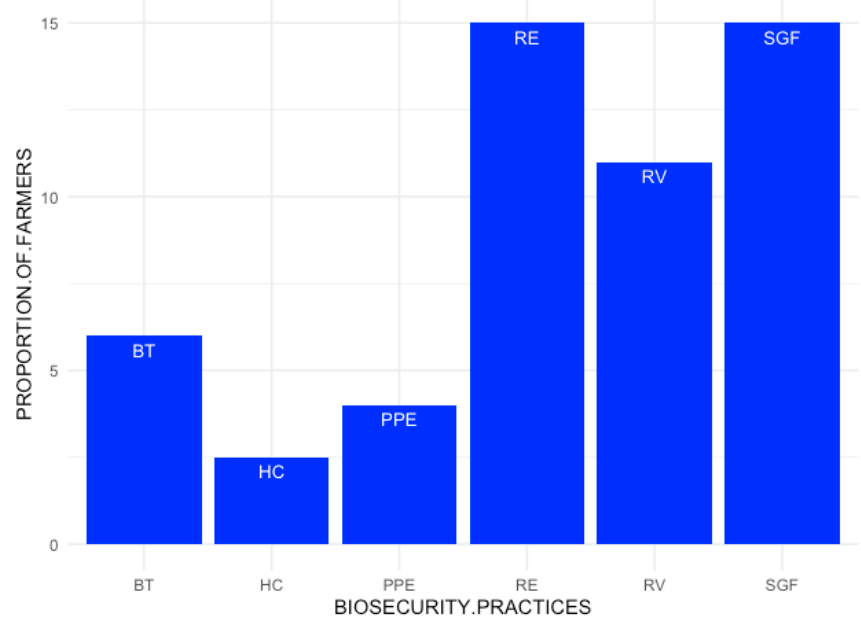
Figure 5. The proportional distribution of the different farm biosecurity practices adopted by the farmers based on the responses received during dairy value chain study conducted in Punjab, India during 2018–2019.